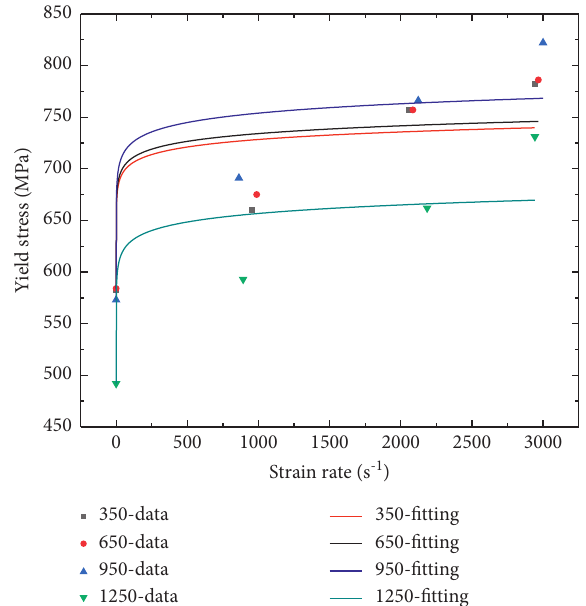
Figure 11: Yield strength and its fitting curve under different strain